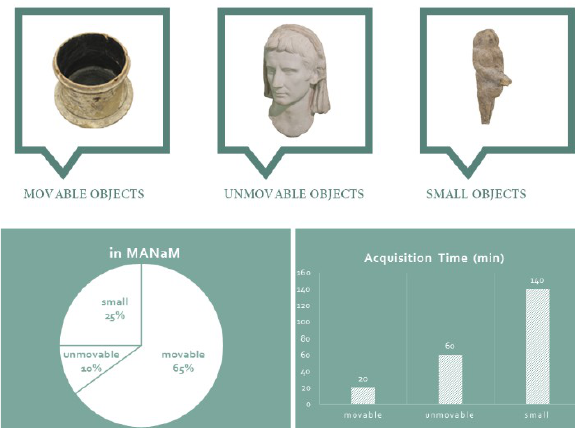
Figure 2. The main categories of archaeological artefacts in the in the National Archaeological Museum of Marche: the percentage of presence (left) and the time of acquisition (right).